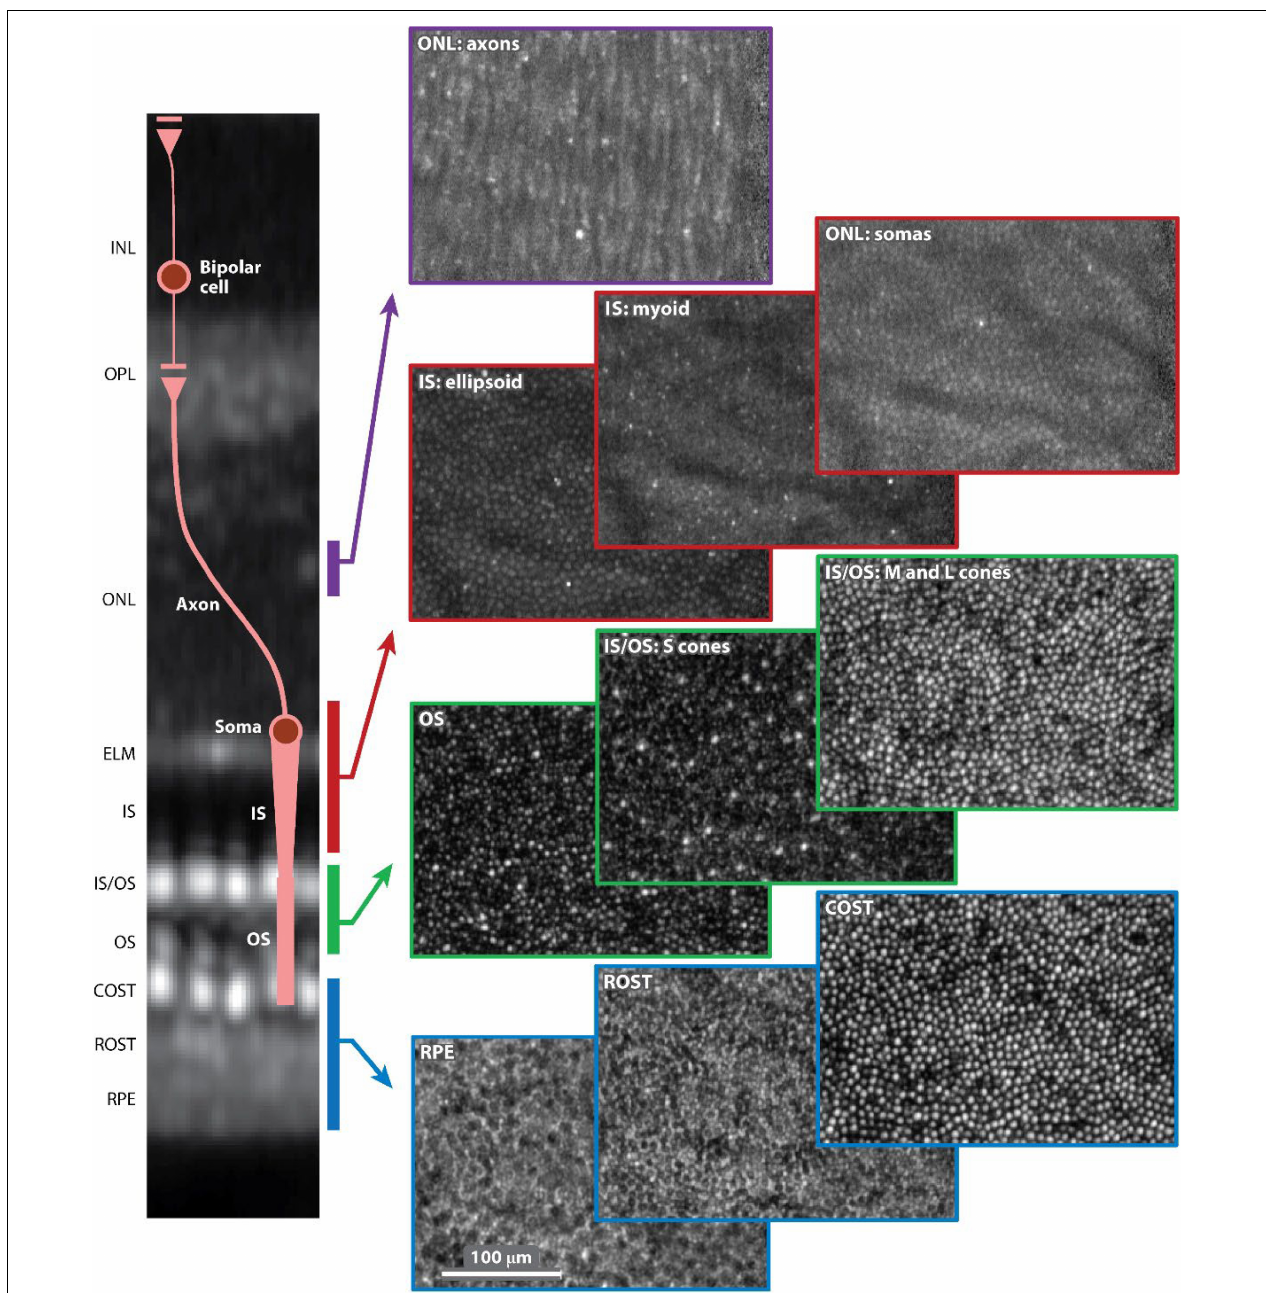
FIGURE 5 | Adaptive optics optical coherence tomography (AO-OCT) volume image of the outer retina of a 52-year-old normal subject. Ten en face (C-scan) images are shown selected from the volume and color-coded by depth in the outer retina, as denoted in the cross-sectional slice (B-scan) on the left. Each C-scan image is normalized to itself and presented on a log intensity scale. The AO-OCT volume image is an average of approximately 2,200 registered volumes that were acquired at 3.7 ◦ temporal to the fovea. AO-OCT, adaptive optics optical coherence tomography; COST, cone outer segment tip; ELM, external limiting membrane; INL, inner nuclear layer; IS, inner segment; IS/OS, inner segment/outer segment junction; ONL, outer nuclear layer; OPL, outer plexiform layer; OS, outer segment; ROST, rod outer segment tip; RPE, retinal pigment epithelium. This figure was reprinted from Miller et al. (262) with permission.